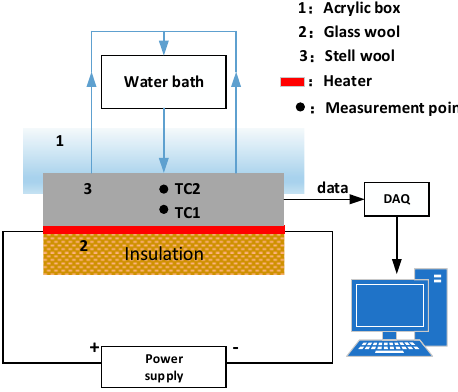
Figure 3. Schematic diagram of the equipment.